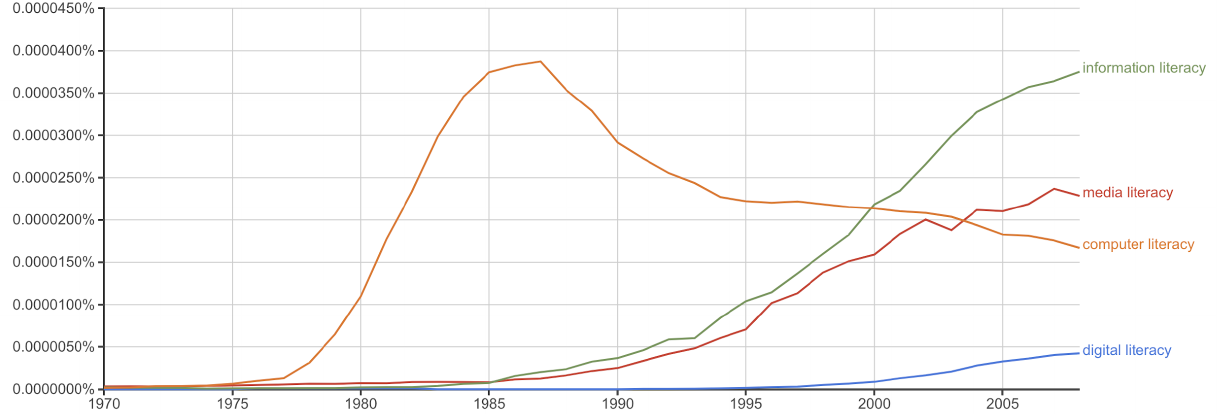
Figure 1. GoogleNGRAM of usage patterns for computer, information, media, and digital literacy between 1970 and 2008.